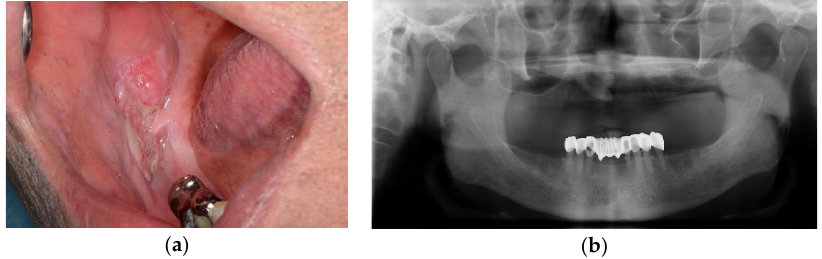
Figure 1. Initial examinations: ( a ) intraoral photograph showed the granulomatous lesion on right lower gingiva; ( b ) no bone invasive lesion was seen in the panoramic view. Incisional biopsy results were diagnosed as SCC. CT and PET-CT were taken. The lesion was confined to soft tissue and lymph nodes in the right submandibular node, with intense fluorodeoxyglucose (FDG) uptake observed on the radiological images. Therefore, marginal mandibulectomy and selective neck dissection (I – Ⅲ ) were planned for the man- agement of the SCC, and a DCIA-based iliac crest flap was planned to reconstruct the resected mandibular site.